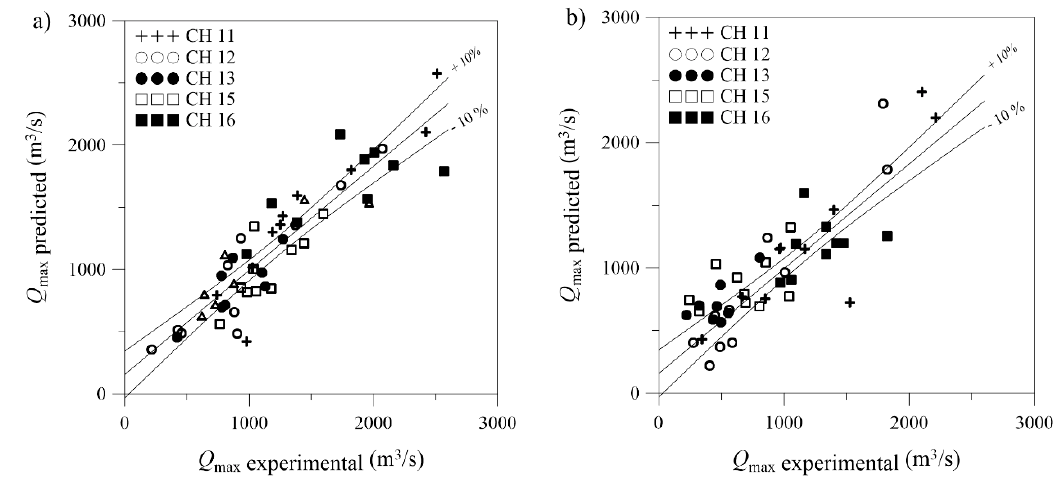
Figure 10. Comparison of calculated and predicted maximum discharge over the dam crest for upstream dam slopes; ( a ) 1 to 1.5 ( R 2 = 0.82) and ( b ) 1 to 2.25 ( R 2 = 0.72) (full scale), with ± 10% deviation. Table 5. Coe ffi cients used in the prediction of Q max for each channel using Equation (7). CH, channel. 1 to 1.5